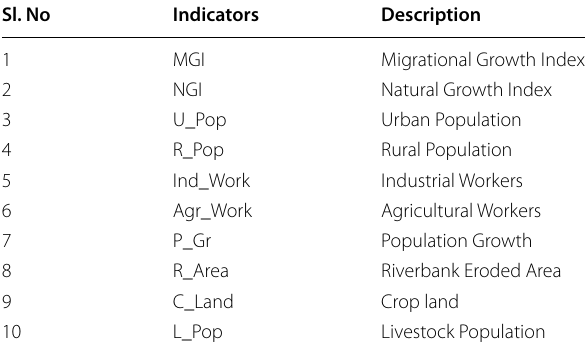
Table 1 Description of variables and indicators for